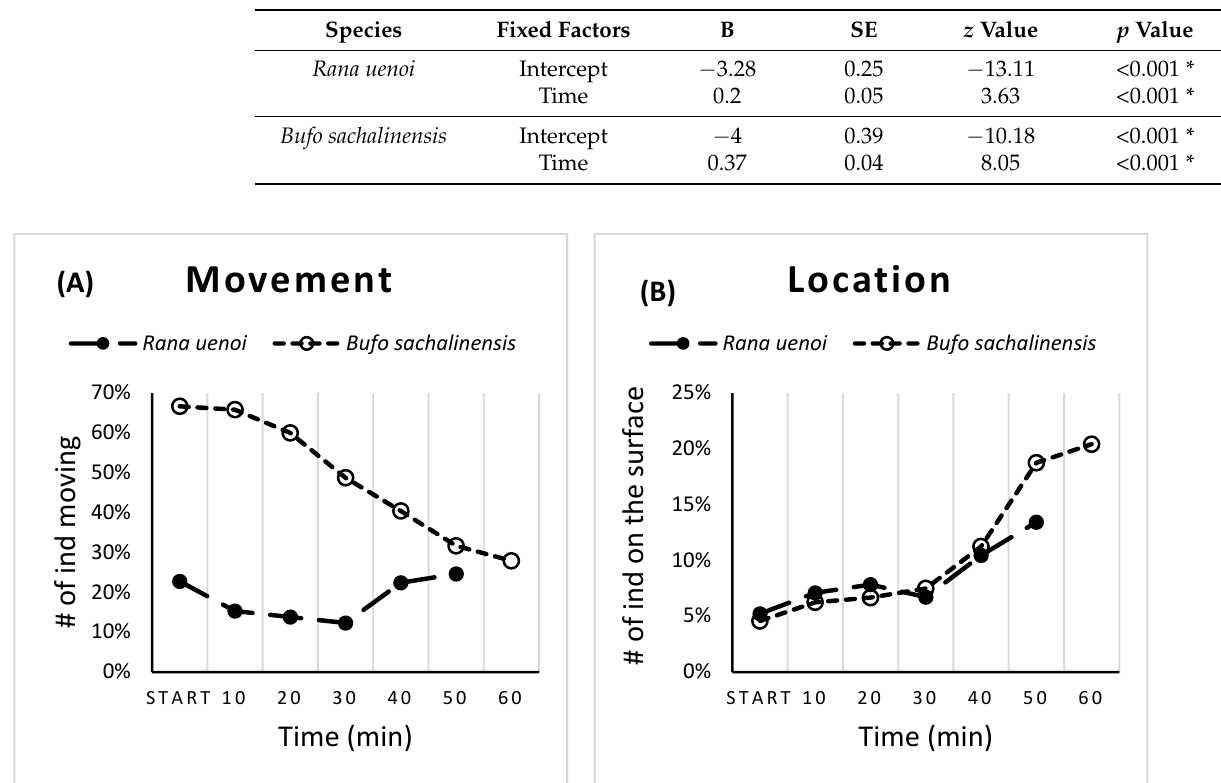
Table 4. Results of the binomial logistic regression assessing the relation between the location (bottom/surface) of tadpoles and time course for Rana uenoi ( n = 268) and Bufo sachalinensis ( n = 240). B = beta coefficient; SE = standard error; significant results are labeled with “*”.